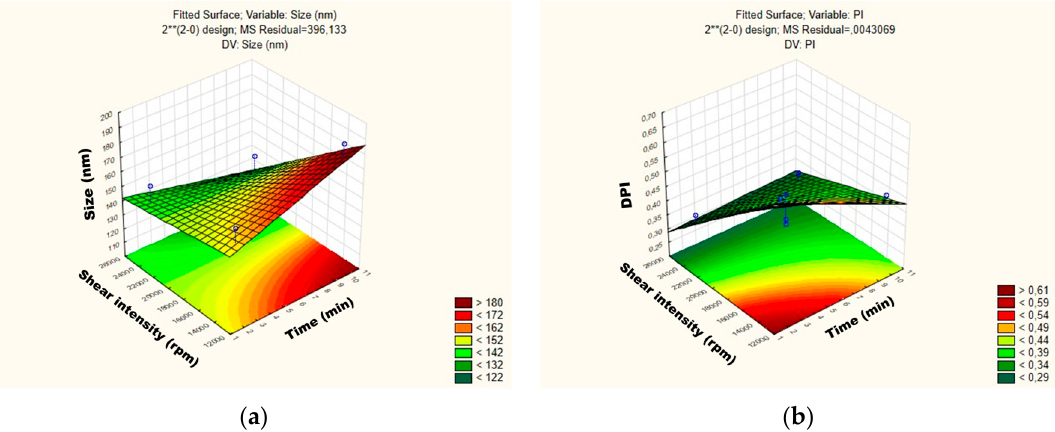
Figure 5. Surface response charts of experimental design of RSV-loaded NLC obtained for ( a ) particle size (Z-average) and ( b ) polydispersity index (PDI).